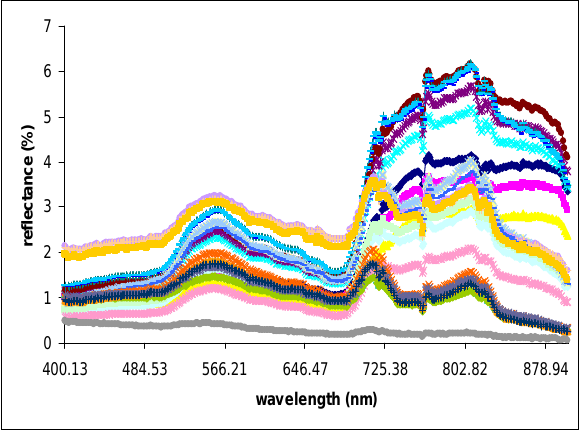
vegetation (SAV) at varying depths. The depth ranged from 0 cm and 30 cm above the SAV canopy; the line for the highest reflectance is at 0 cm and the reflectance continuously decreases with water depth